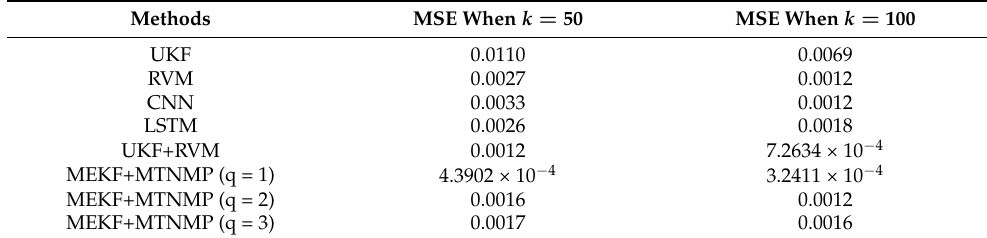
Table 4. Experimental results of the B0006 lithium-ion battery.